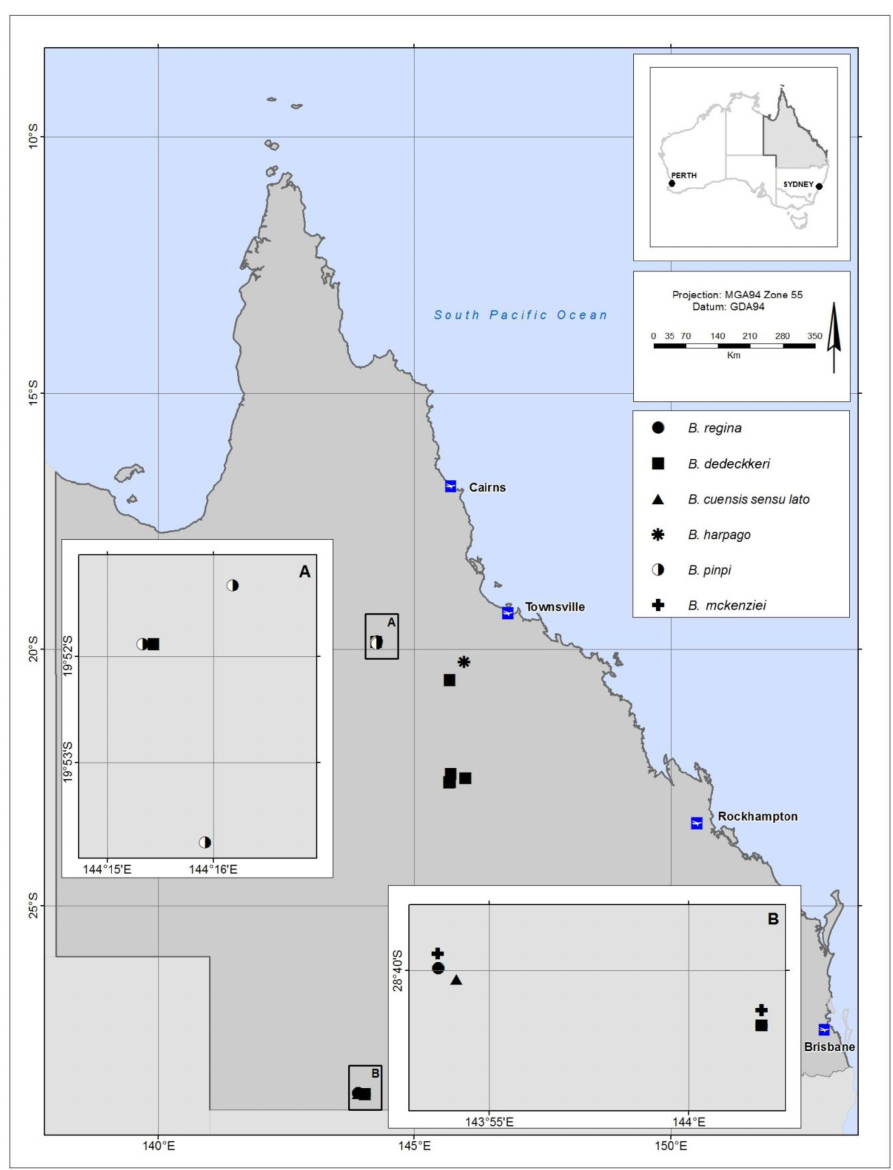
Fig. 1. Map of localities of Bennelongia species from eastern Australia recorded in the present